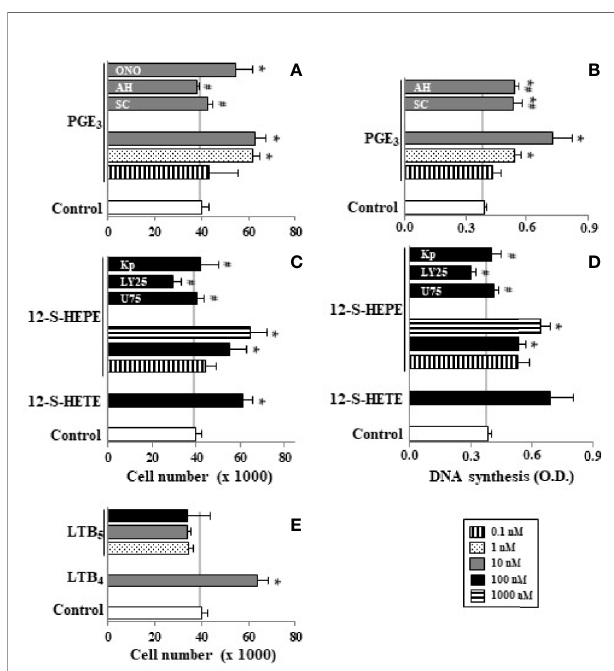
FIGURE 5 | Effect of PGE 3 , 12-S-HEPE, and LTB 5 on Caco-2 cell growth. Caco-2 cells were incubated for 48 h with PGE 3 (0.1, 1, and 10 nM, line, dot, and gray bars, respectively) or PGE 3 (10 nM) plus SC19220 (SC, 60 nM) or AH 23848 (AH, 20 nM) or ONO-AE3-240 (ON, 2 nM) or with 12-S-HEPE (10, 100, and 1000 nM, line, gray, and dot bars, respectively) or with 12-S-HEPE (100 nM, gray bar) plus U 75302 (U, 5 µM) or LY 255283 (LY, 25 µM) or ketoprofen (Kp, 5 µM). Cell cultures were also incubated with LTB 5 (1, 10,and 100 nM, dot, gray, and black bars, respectively) or LTB 4 (10 nM, gray bar) in absence of FBS. Finally, cells were then counted (A, C, E) and DNA synthesis was measured (B, D) . Data are expressed as means ± SEM of three to four experiments performed in triplicate. *P < 0.05 vs. Caco-2 cell cultures in the absence of FBS, # P < 0.05 vs. cells incubated with 10 nM PGE 3 or